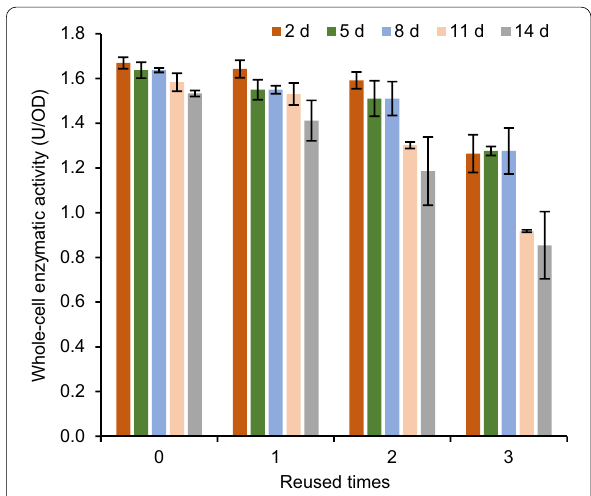
Fig. 4 Repeated use of the InaPbN-CESH[L] surface display system. The cells after protein expression were incubated at 4 °C for different days and then the whole-cell enzyme activities were repetitively assayed four times. After each enzymatic reaction, the cells were centrifuged and washed with the assay buffer, and then the whole-cell enzyme activities were immediately assayed again